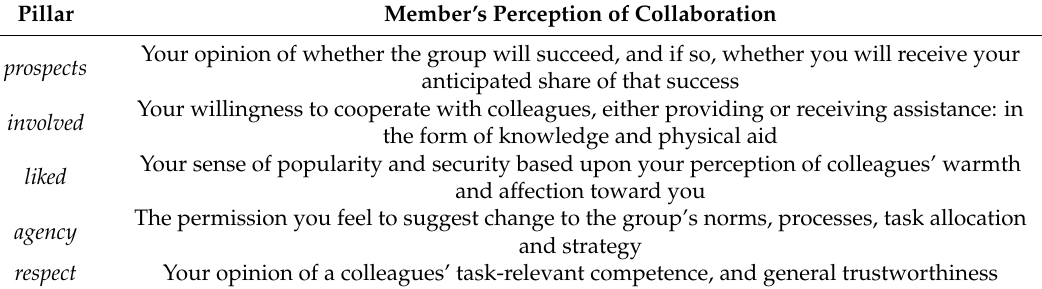
Table 1. Definition of each